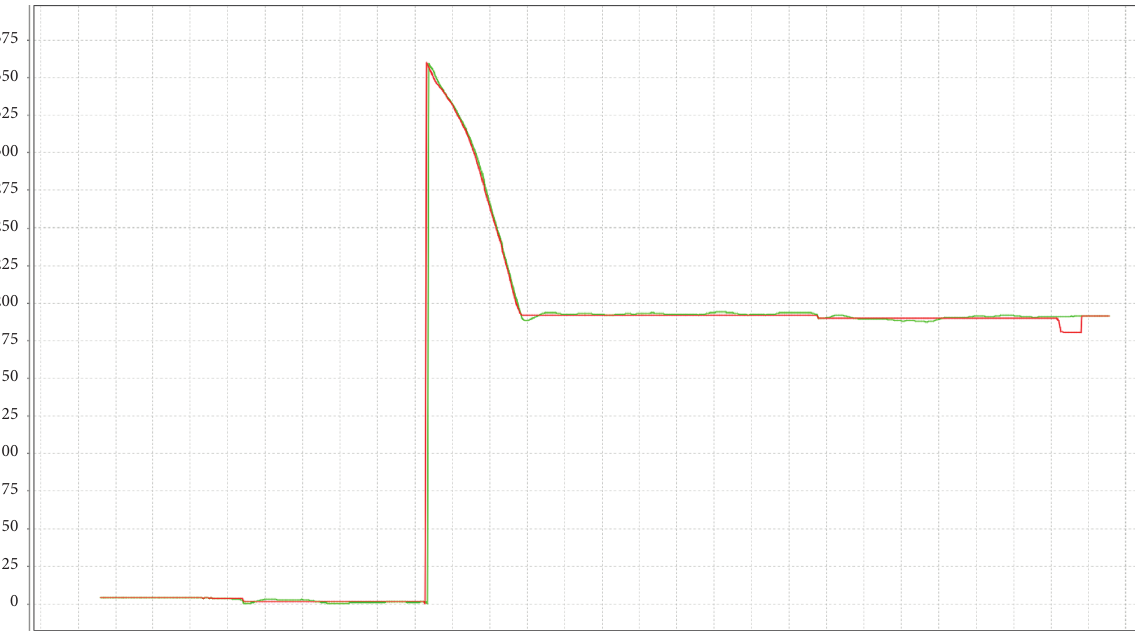
Figure 21: Actual flight yaw angle